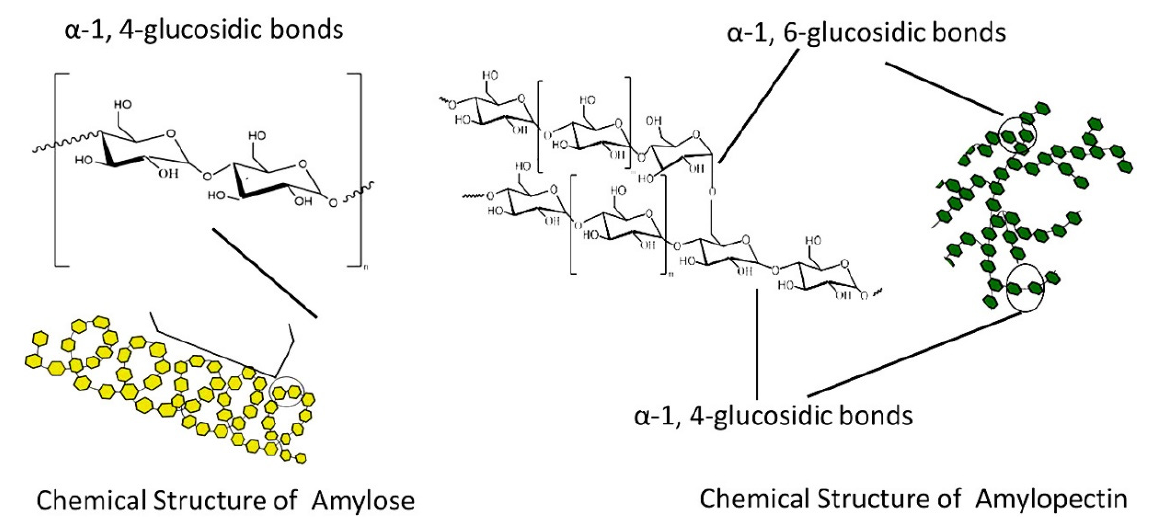
Figure 9. Chemical structure of starch with amylose, and amylopectin. Dextrin